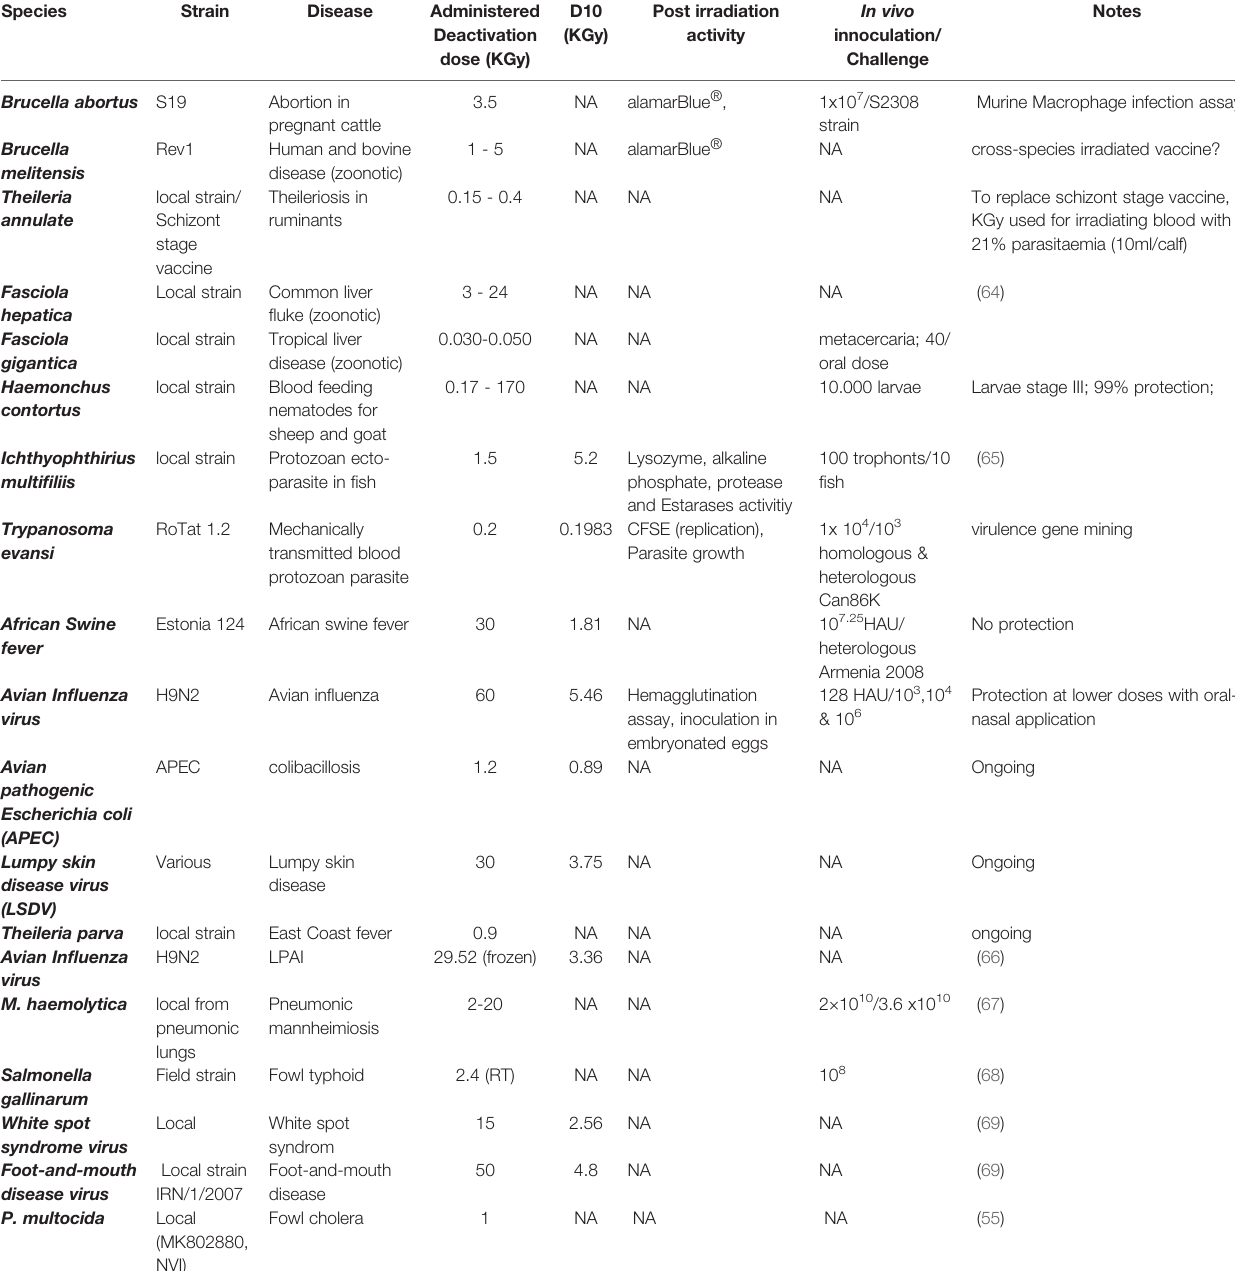
TABLE 1 | Comparison of different irradiation experiments carried out by IAEA and partners.